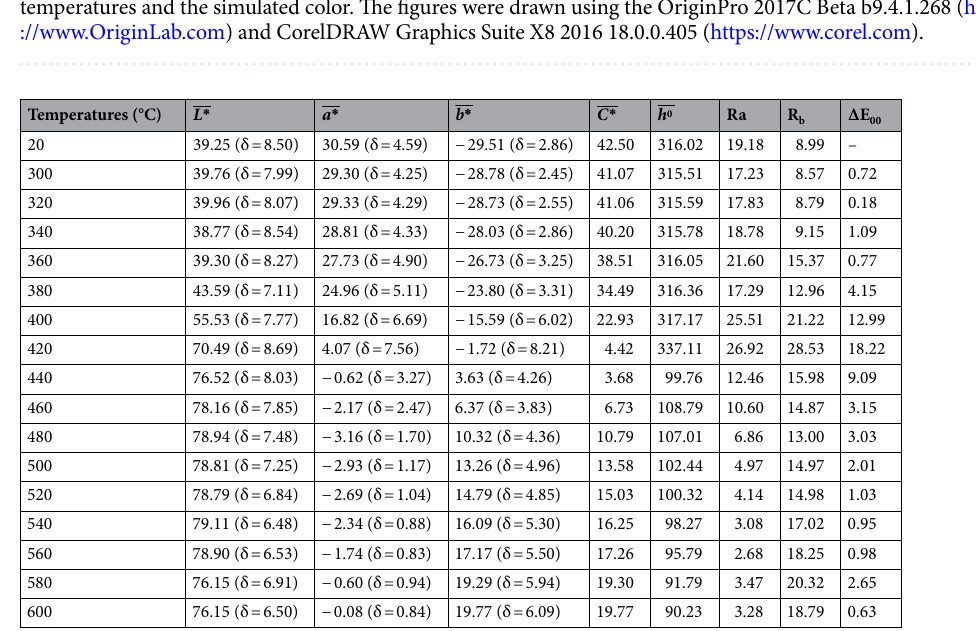
Table 3. Mean value of color parameters, R a , R b and color difference (ΔE 00 ) at different